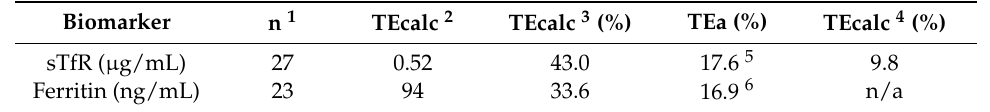
Table 2. Total calculated analytical error (TEcalc) for iron deficiency anemia (IDA) biomarkers measured on the PC biosensor against established quality specifications for total allowed error